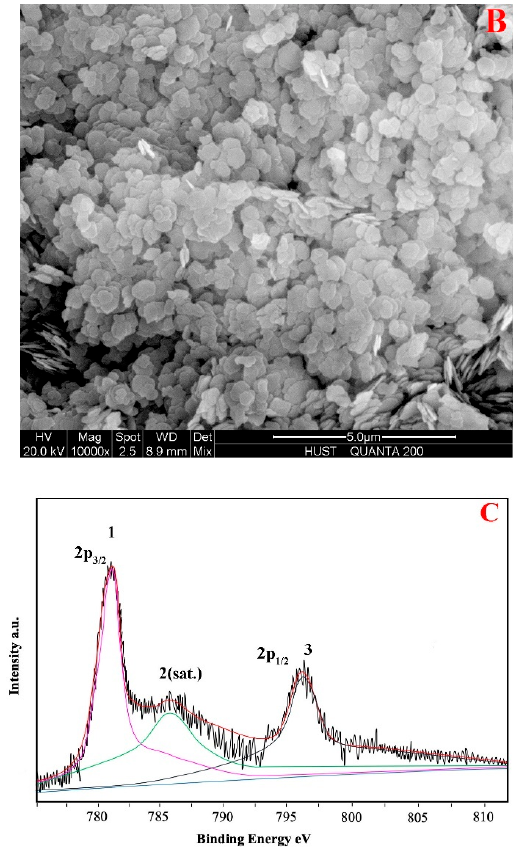
Figure 1. ( A ) X-ray diffraction (XRD) patterns of CoMgAl-LDH, ( B ) scanning electron microscope (SEM) images of CoMgAl-LDH, and ( C ) X-ray photoelectron spectroscopy (XPS) analysis of CoMgAl-LDH.